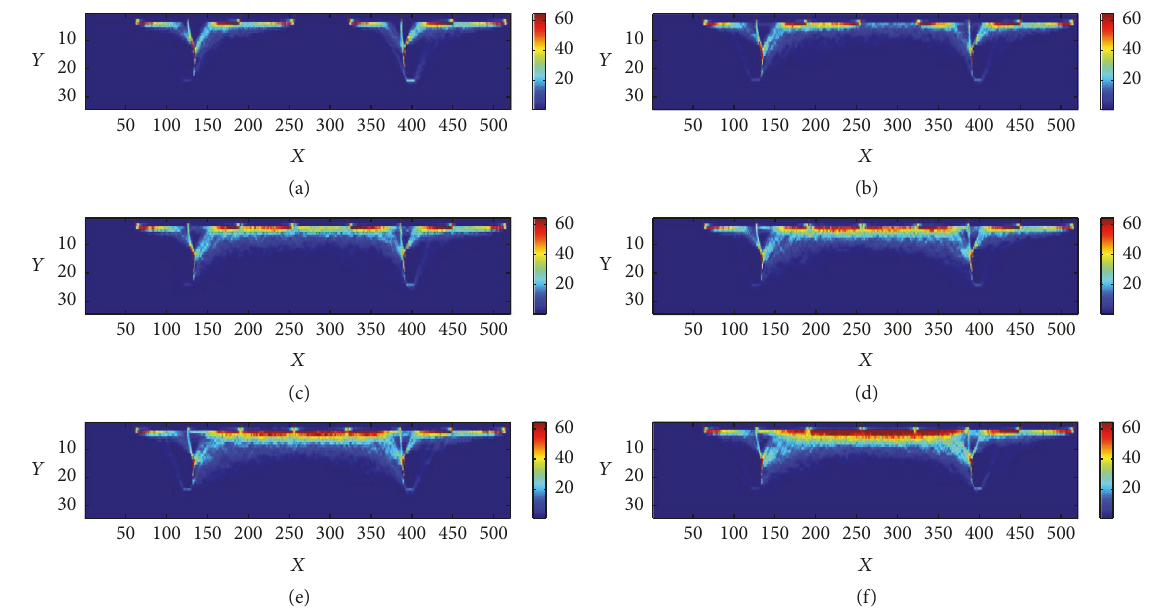
Figure 13: CD 𝑖,𝑗 under different 𝑝 , where 𝑝 in (a)–(f) are, respectively, 0, 0.1, 0.2, 0.3, 0.4, and